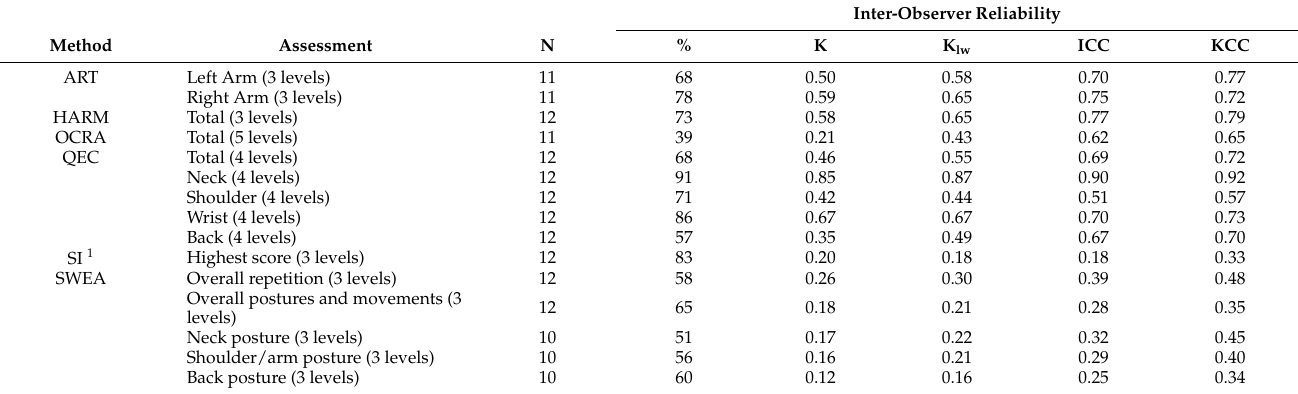
Table 4. Inter-observer reliability of risk levels, with pre-given specific differing work task durations for the ten work tasks (See Table 2). The item ratings were first used to compute the risk scores for each method and were then transposed into risk levels according to the instructions for each of the methods. Number of ergonomists (n), proportional agreement (%), Cohen’s kappa (K), linearly weighted kappa averaged over pairs (K lw ), intraclass correlation (ICC) and Kendall’s coefficient of concordance (KCC) for the results of the ergonomists’ ratings of the ten different video-recorded work tasks.